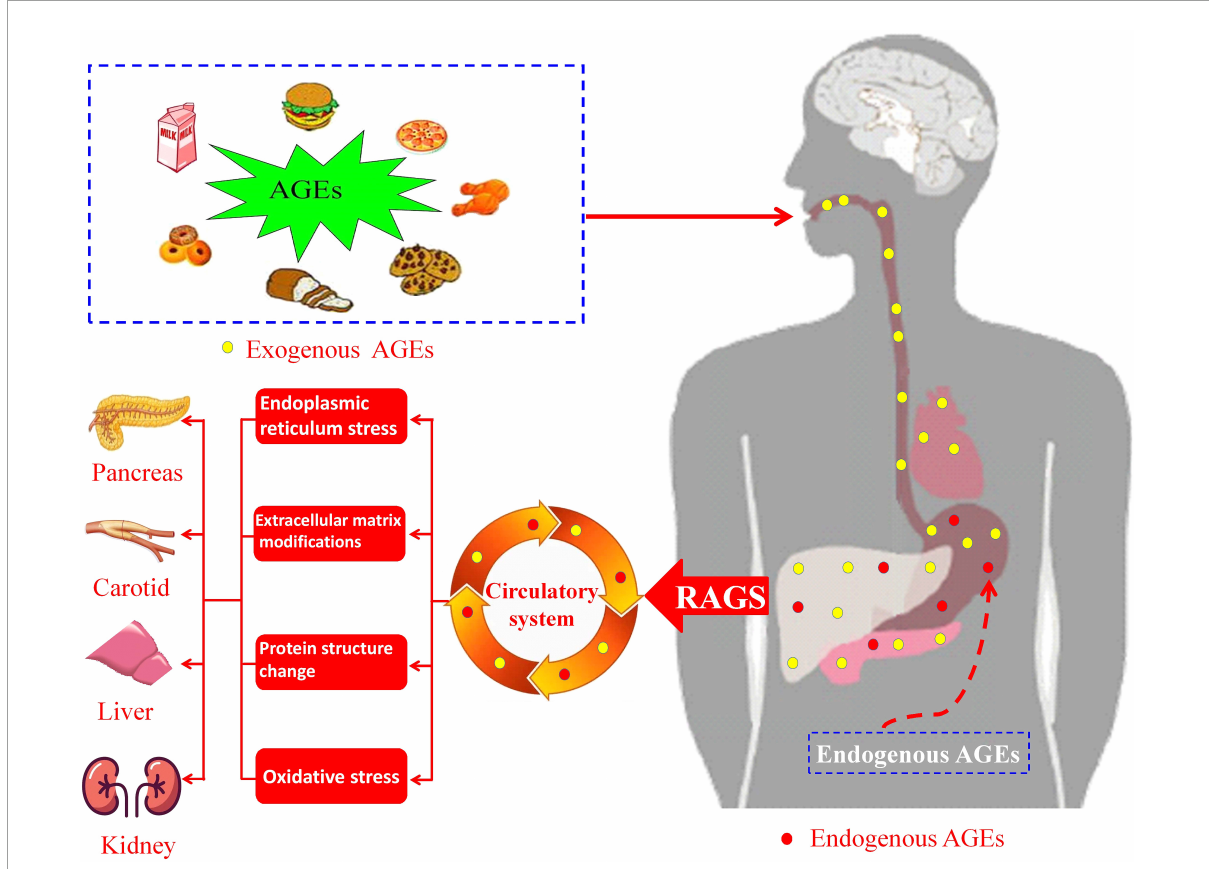
FIGURE1 Schematic pathway of advanced glycation end products (AGEs) intake and formation in human body and AGEs-induced